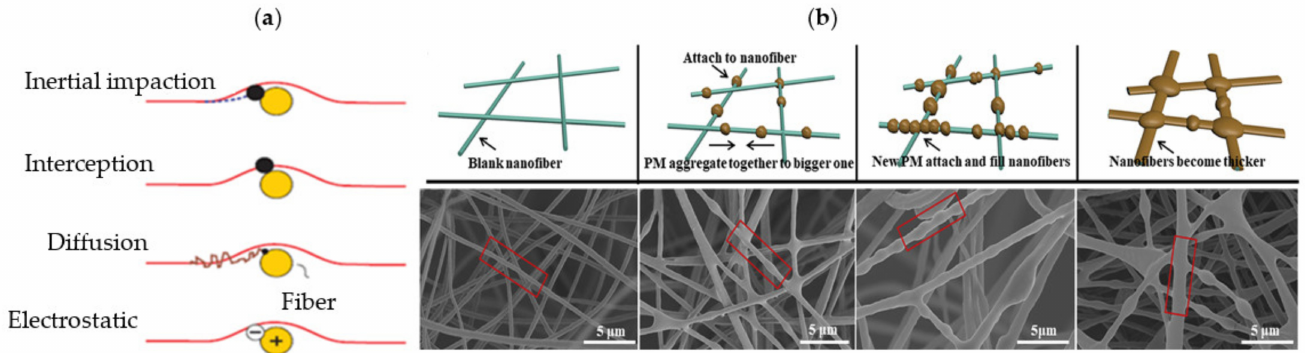
Figure 5. Mechanisms of particle filtration: ( a ) five collections of mechanism, and ( b ) interaction of PM with nanofibers (adapted with permission from Reference